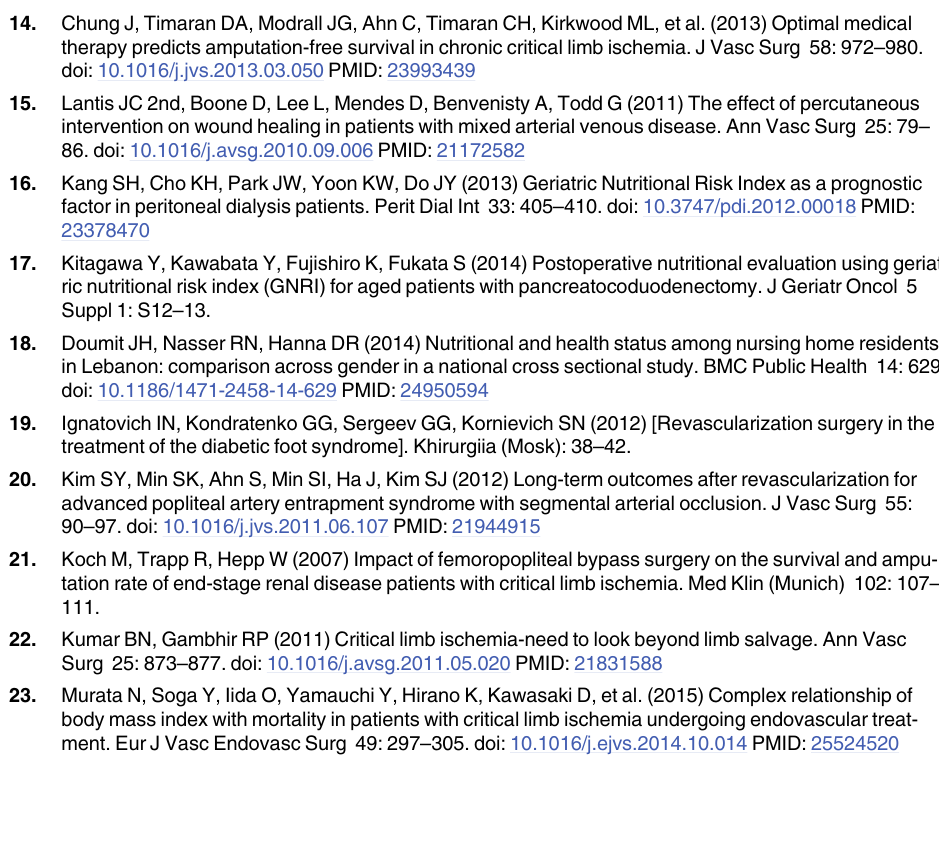
PLOS ONE | DOI:10.1371/journal.pone.0152111 March 24,